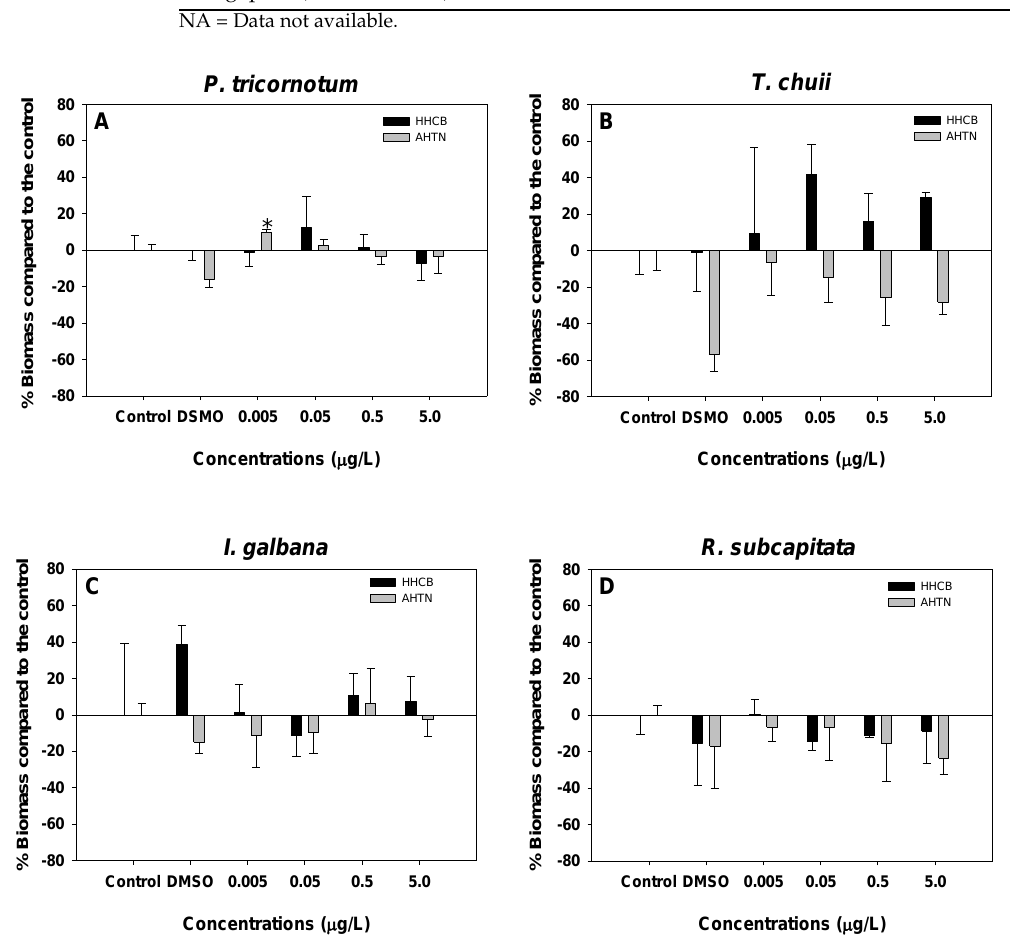
Figure 1. A-1D: Microalgae exposed to galaxolide and tonalide for growth inhibition tests after 72 h. Biomass (%) compared to the control of ( A ) P . tricornotum, ( B ) T. chuii, ( C ) I. galbana, and ( D ) R. subcapitata (negative values corresponding to % growth inhibition). Asterisks (*) indicate significant differences ( p < 0.05) in relation to